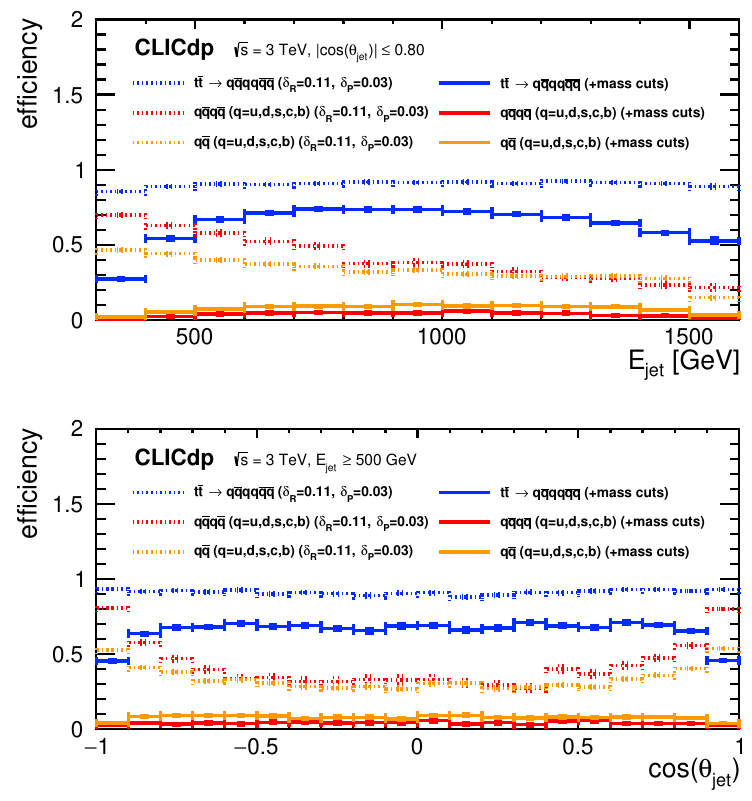
Figure 9. Top tagger e(cid:14)ciency for fully-hadronic tt events (blue), four-jet events (red), and dijet events (orange) as function of jet energy (top) and jet polar angle (cid:18) (bottom). The dashed lines show the e(cid:11)ect of applying the de-clustering procedure outlined in the text, while the solid lines show the e(cid:14)ciency including also the cuts on the reconstructed invariant mass of the top-quark and W